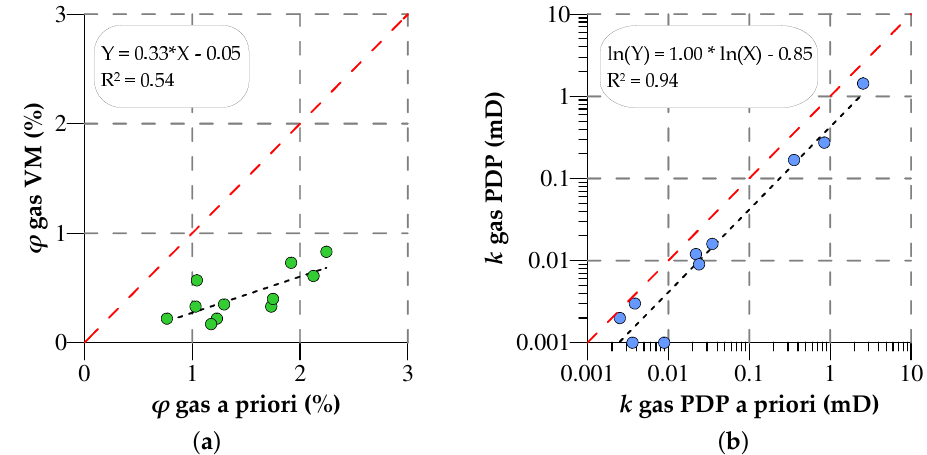
Figure 14. Gas volumetric (VM) porosity ( a ) and gas permeability ( b ) cross plots for core plugs show a comparison between the obtained data and the legacy